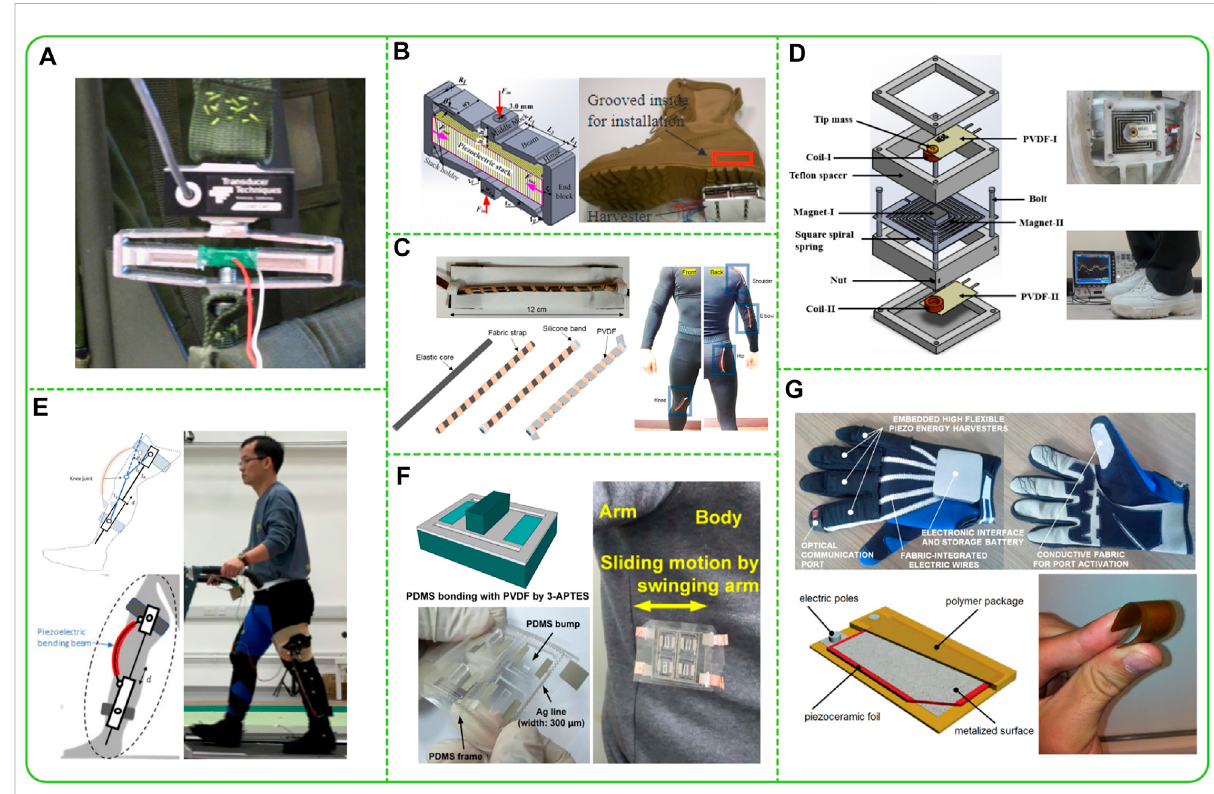
FIGURE 2 PiezoelectricEHfromhumanmotion. (A) Fieldtestphotographoftheenergyharvestingbackpack(Feenstraetal.,2008). (B) Forceampli fi cation frameand fi eldtestphotographoftheproposedpiezoelectricfootwearharvester(Qianetal.,2018). (C) Fabricationprocess,prototype,andfrontand back views of HPEH (Iqbal et al., 2020). (D) Exploded view and Photographs of the HIEH incorporated into the sole of a commercial shoe, and the experiment setup (Kim and Yun, 2017). (E) Schematic diagram of the piezoelectric bending beambased energy harvester when being equipped on the human body and fi eld test photograph (Kim et al., 2018). (F) Schematic diagram, fabricated fl exible harvester array and implementation of the proposed harvester (Gao et al., 2022). (G) Prototype and piezoelectric material of GoldFinger (De Pasquale et al.,